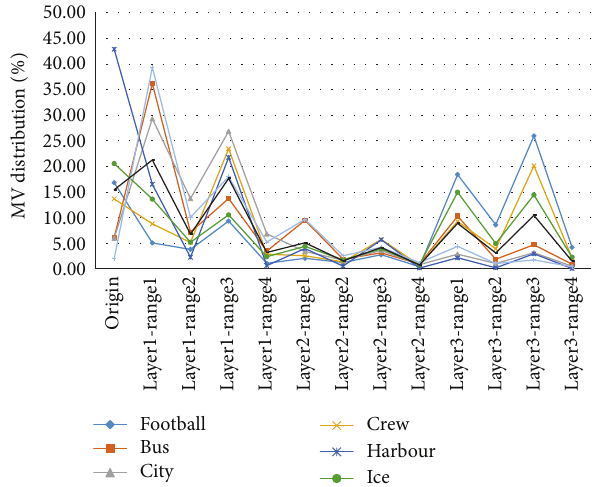
Figure 4: MV distribution curves of each sequence.